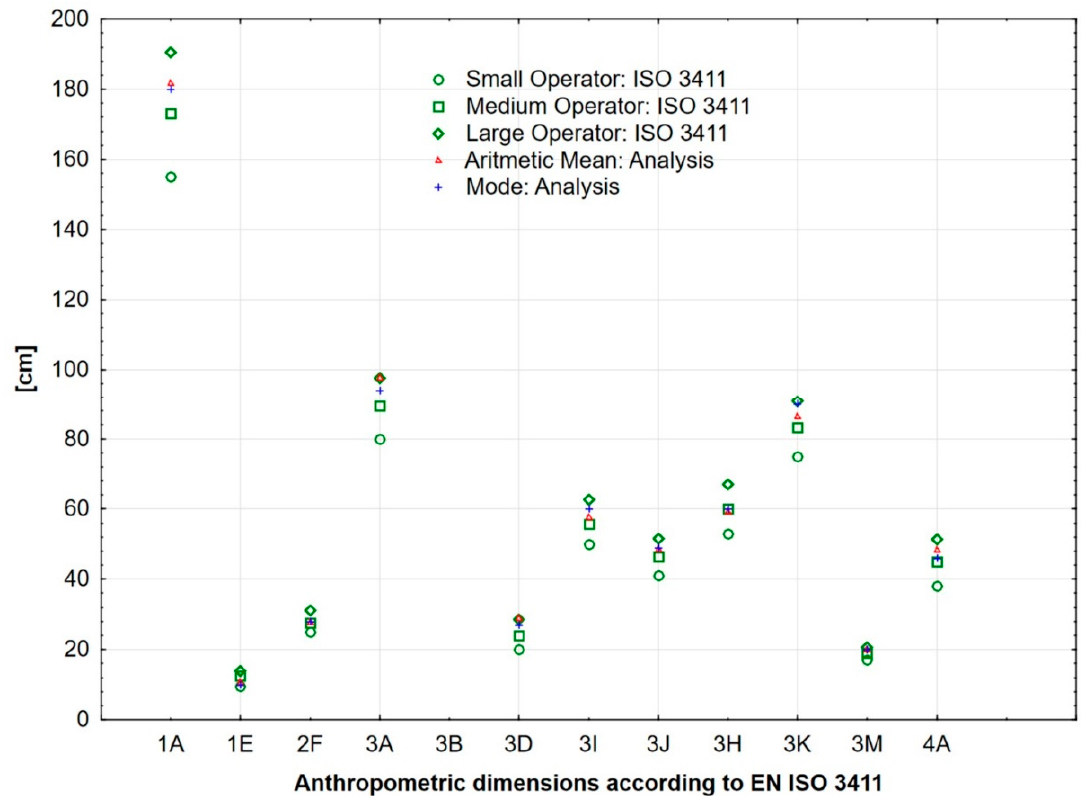
Figure 5. Range of anthropometric dimensions according to EN ISO 3411 compared to statistical values from the analysis of the male population (2002–2019).